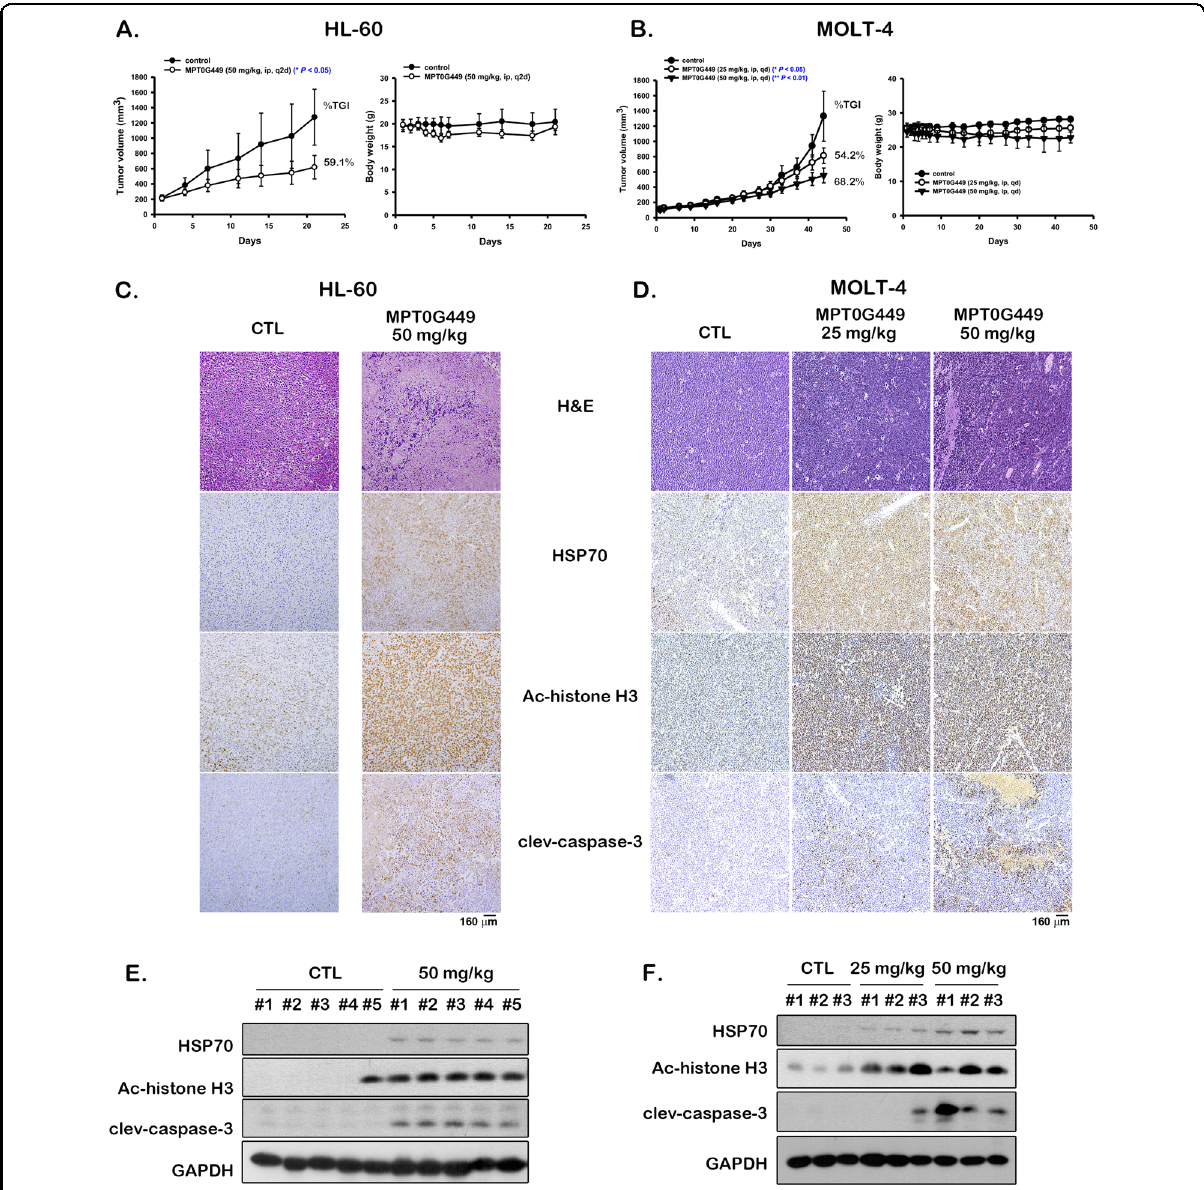
Fig. 6 MPT0G449 exhibited anti-tumor activity in HL-60 and MOLT-4 xenograft models. Severe combined immunode fi ciency (SCID) mice were subcutaneously injected with 1 × 10 7 HL-60 or MOLT-4 cells. After tumor size reached approximately 200 mm 3 , mice received vehicle or MPT0G449 (25 or 50 mg/kg by intraperitoneal (i.p.) injection) in HL-60 ( A ) or MOLT-4 ( B ) models. Tumor size was measured twice per week and body weights were measured daily during the fi rst week and then twice per week. Tumor growth inhibition (TGI) was represented as mean ± S.E. * p < 0.05 and ** p < 0.01 as compared with the control group. Tumors were harvested at terminal sacri fi ce and biomarker proteins were subjected to IHC stain and western blotting. Expression levels of biomarkers of MPT0G449 in HL-60 ( C , E ) and MOLT-4 ( D , F )